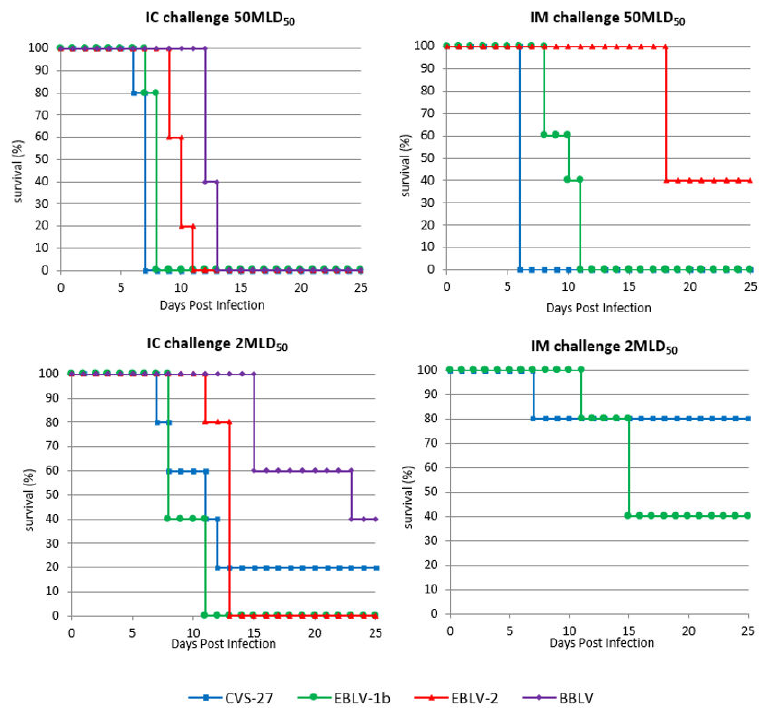
Figure 1. Pathogeny of challenge virus standard 27 strain (CVS-27), European bat lyssavirus 1 (EBLV-1b), European bat lyssavirus 2 (EBLV-2), and Bokeloh bat lyssavirus (BBLV) in unvaccinated Swiss OF-1 mice ( n = 5 mice / group). Animals were challenged with either 50 MLD 50 by the intracerebral (IC) route ( a ) and the intramuscular (IM) route ( b ), or 2 MLD 50 by the IC route ( c ) and the IM route ( d